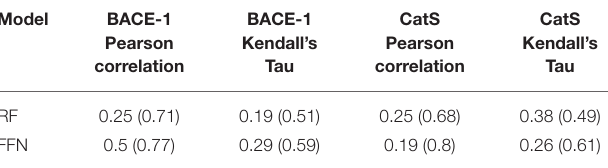
TABLE 4 | GC4 BACE-1 and CatS performance